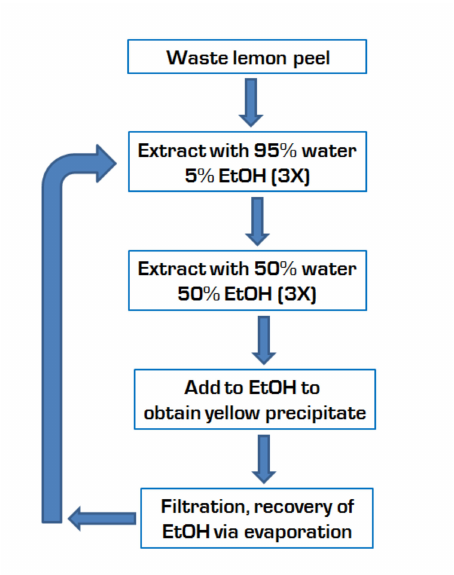
Scheme 1. The extraction of yellow #15 from waste lemon peel and recovery of ethanol used as co-solvent.